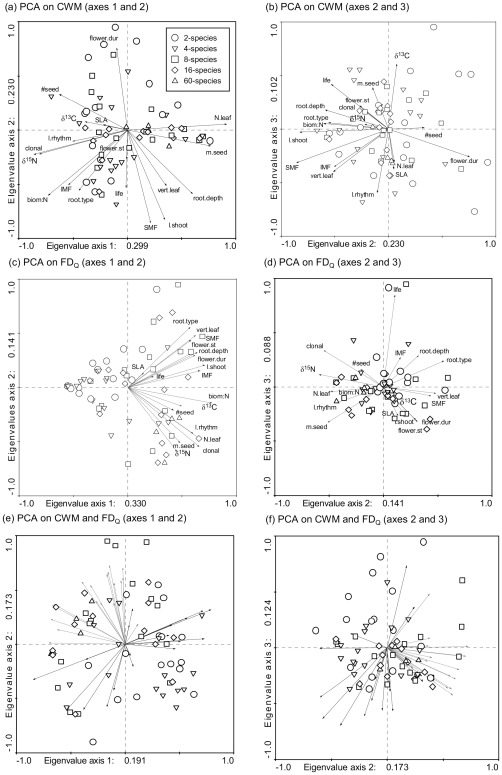
Standardized Principal Components Analysis (PCA) of community-weighted means of trait values (CWM) and functional trait diversity based on Raòs quadratic entropy (FDQ) of experimental grassland communities.PCA of community-weighted means of trait values (CWM) first vs. second axes (a), second vs. third axes (b), PCA of functional trait diversity (FDQ) first vs. second axes (c), second vs. third axes (d), and PCA of CWM and FDQ in combination first vs. second axes (e), second vs. third axes (f). Community-weighted means of trait values (CWM) and functional trait diversity (FDQ) were calculated for each community based on species biomass proportions in the mixture and functional traits measured in species monocultures in the Jena Experiment and derived from the literature. Symbols show the position of each community sown with different numbers of species. Black arrows show CWM, red arrows show FDQ for each trait.